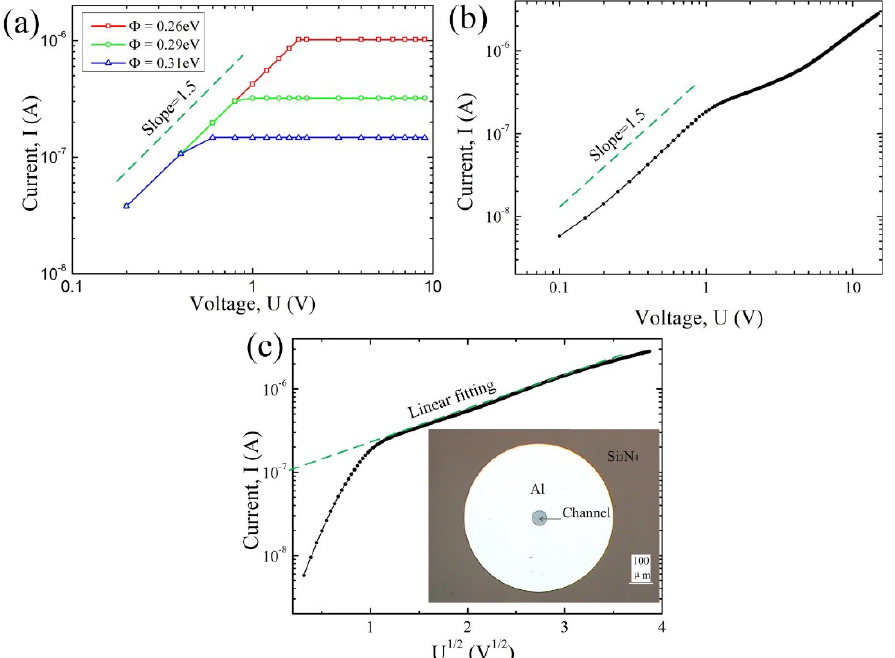
Figure 2. I − U curve of the proposed vacuum diode under room temperature. ( a ) Simulated results of I − U characteristics with different equivalent work functions. ( b ) Measured I − U characteristics in a lg − lg plot. ( c ) Measured I − U characteristics in a lg I − U 1/2 plot. The inset is a picture of the diode taken by metallographic microscope. The linear relationship indicated the barrier − lowering effect mechanism.